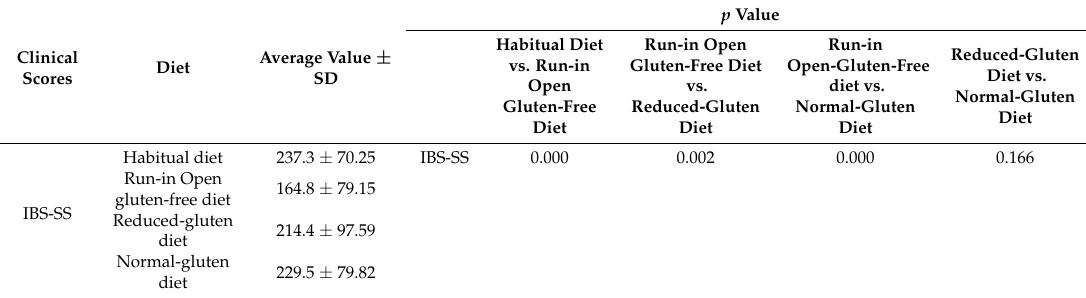
Table 3. Modification of the clinical scores 1 in the IBS patients in the different diets according to the challenge